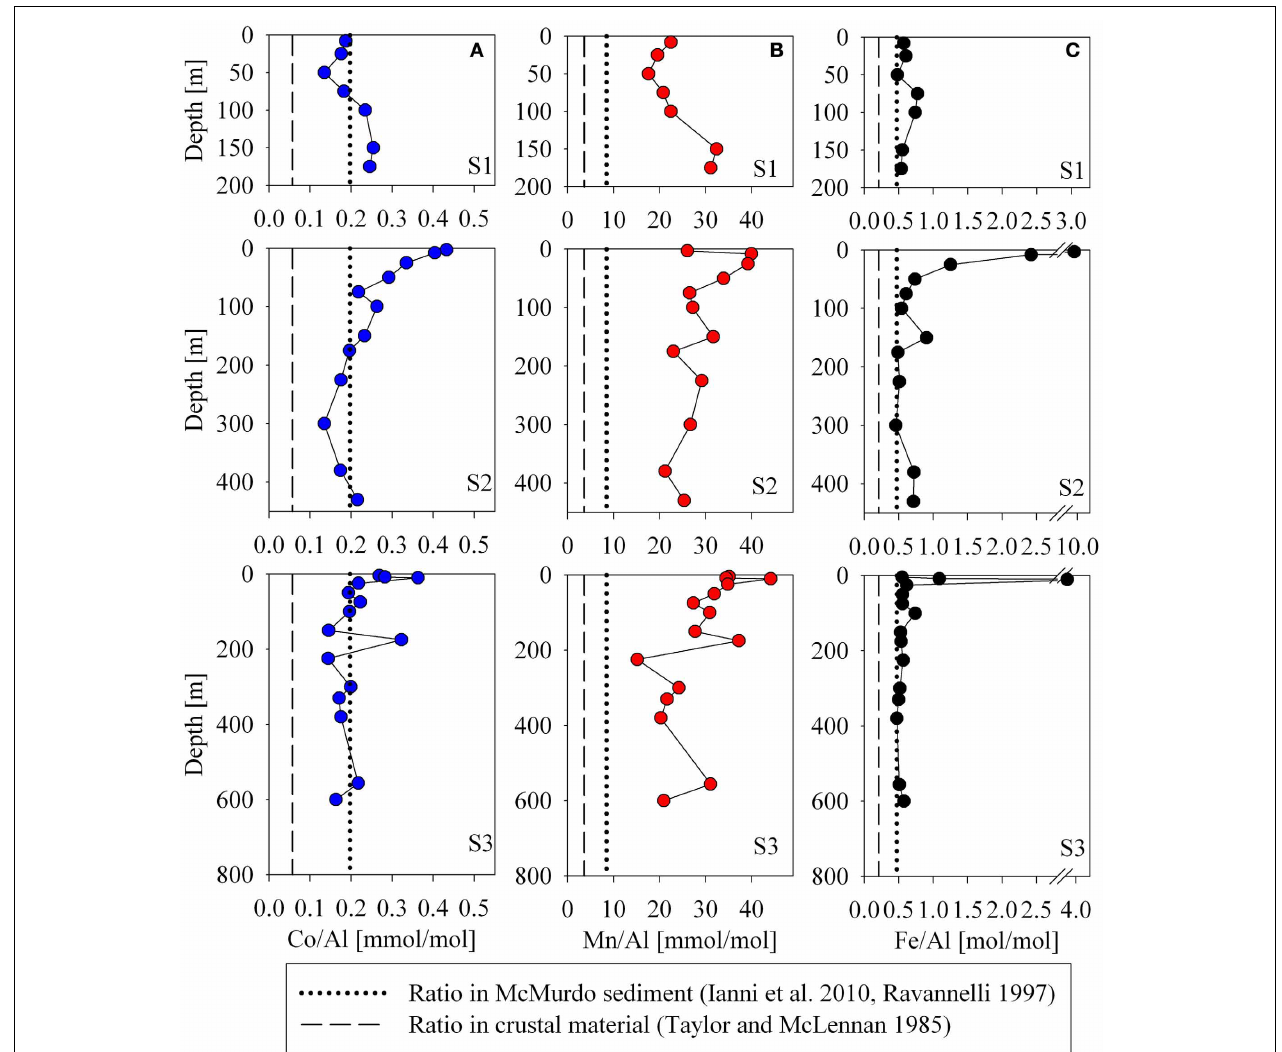
FIGURE 11 | Aluminum normalized particulate metal profiles for cobalt (A), manganese (B), and iron (C). The Fe/Al ratios are similar the sediment composition value for two Ross Sea sediment core study sites (dotted lines, Ravanelli et al., 1997; Ianni et al., 2010), but both